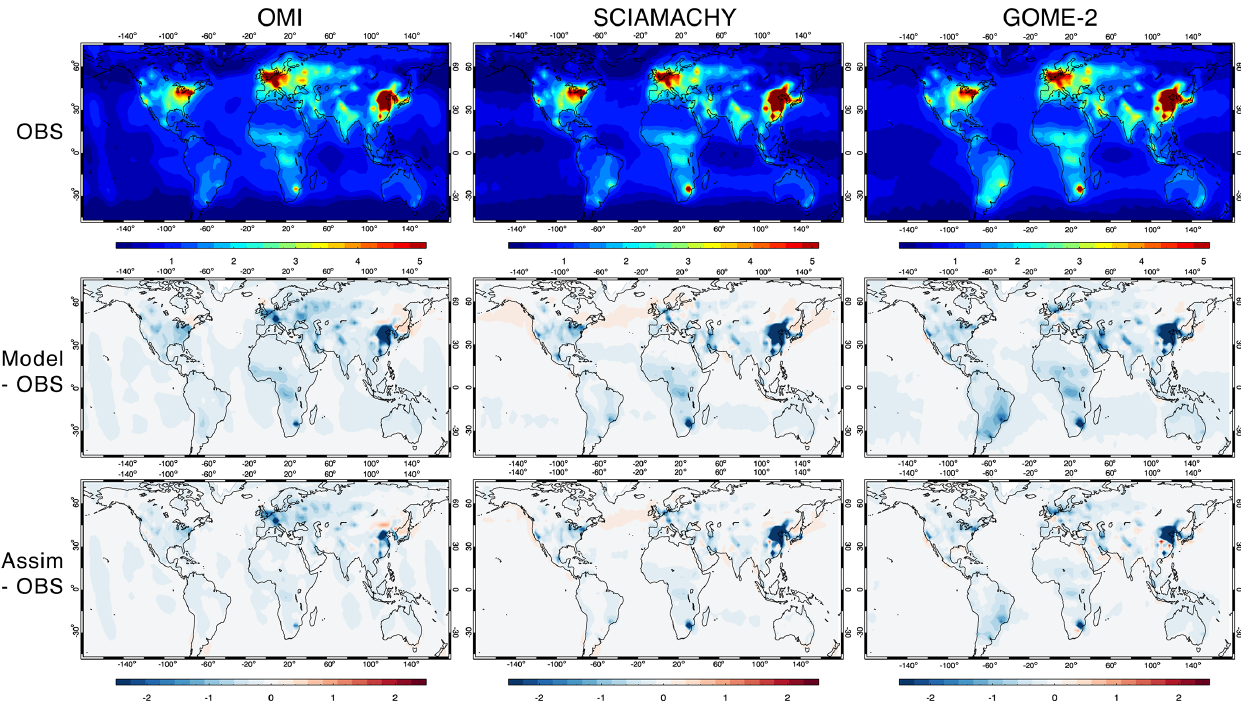
Figure 2. Global distributions of the tropospheric NO 2 columns (in 10 15 moleccm − 2 ). The results are shown for OMI (left columns, sam- pling time ≈ 13:00LT) for 2005–2014, SCIAMACHY (middle columns, 10:00LT) for 2005–2011, and GOME-2 (right columns, 09:30LT) for 2007–2014. Upper row shows the tropospheric NO 2 columns obtained from the satellite retrievals (OBS), centre row shows the difference between the model simulation and the satellite retrievals (Model–OBS); and lower row shows the difference between the data assimilation and the satellite retrievals (Assim–OBS).